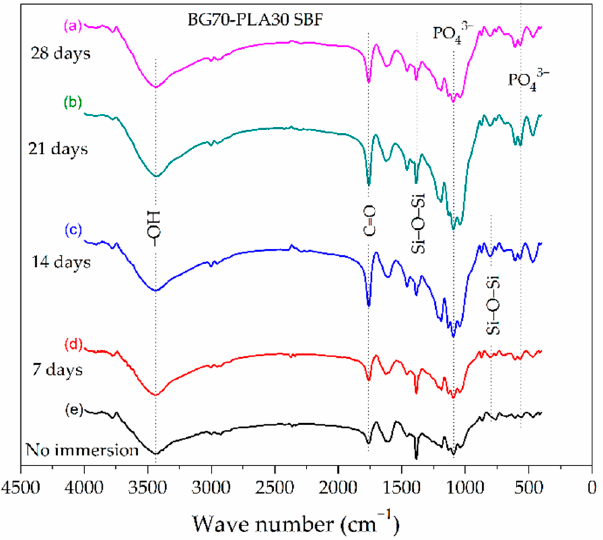
Figure 3. FTIR spectra of the BG70-PLA30 composite after different soaking times in SBF.